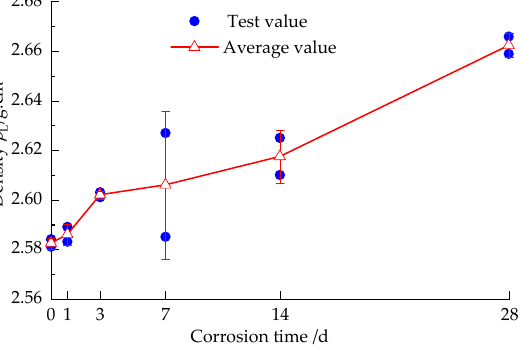
Figure 2. Change of the density of sandstone after solution